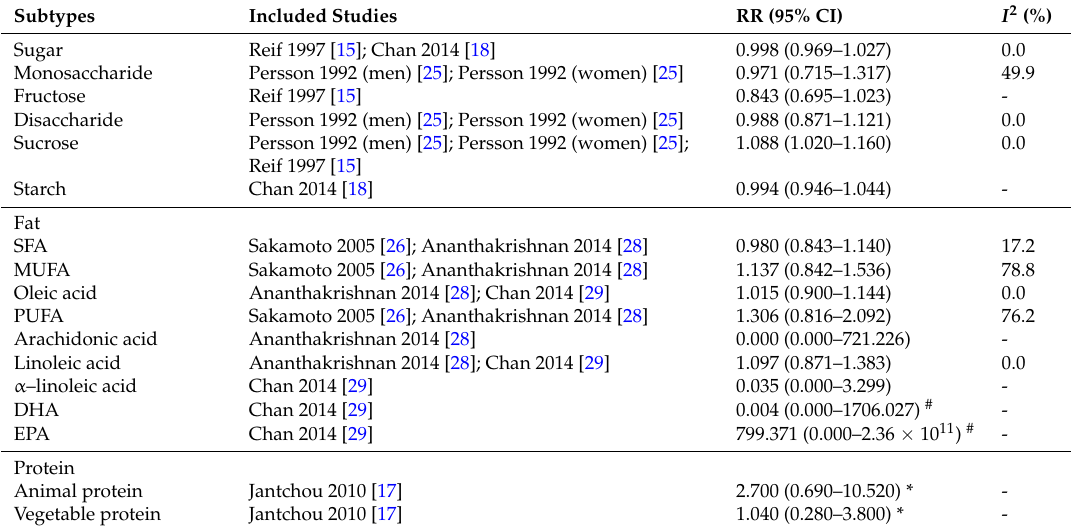
Table 2. Intake of the nutrients’ subtypes (per 10 g increment/day) and the risk of Crohn’s disease.